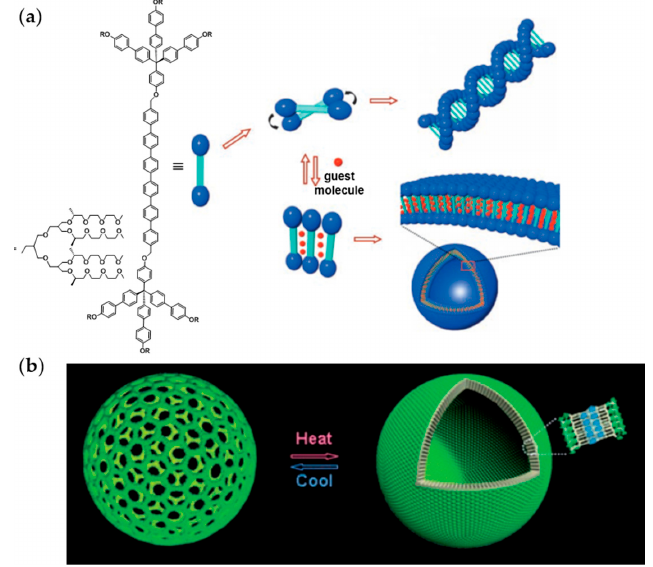
Figure 4. ( a ) Self-assembly of symmetric amphiphilic dumbbells in aqueous solution: helical nanofibers without guest molecules or vesicles after addition of guest molecules [34]. ( b ) Temperature-induced reversible closing of pores in a vesicle membrane [40]. Copyright Wiley-VCH, adapted from Angewandte Chemie International Edition 2006 [34] and reprinted from Angewandte Chemie International Edition 2008 [40].